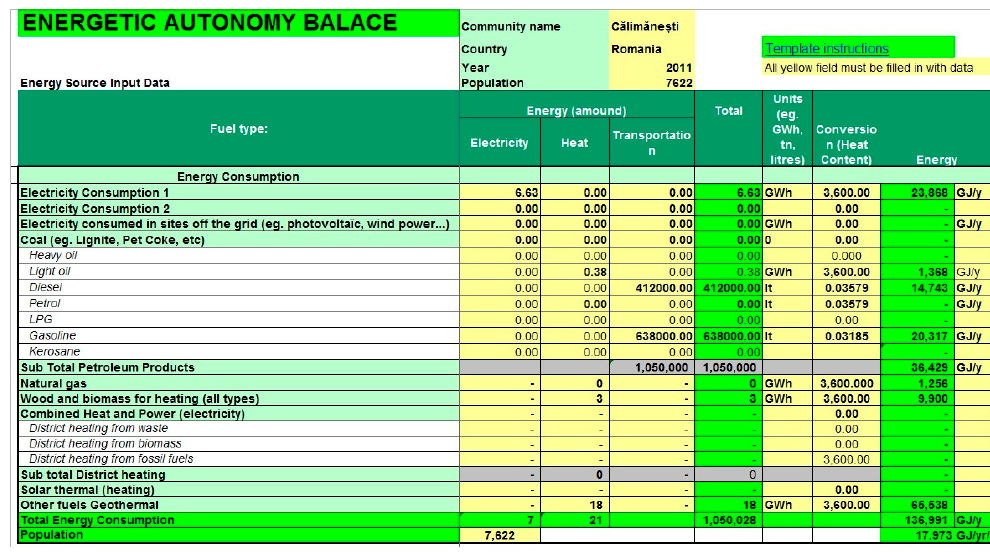
Figure 12. Energy consumption of Calim ă ne ș ti town.